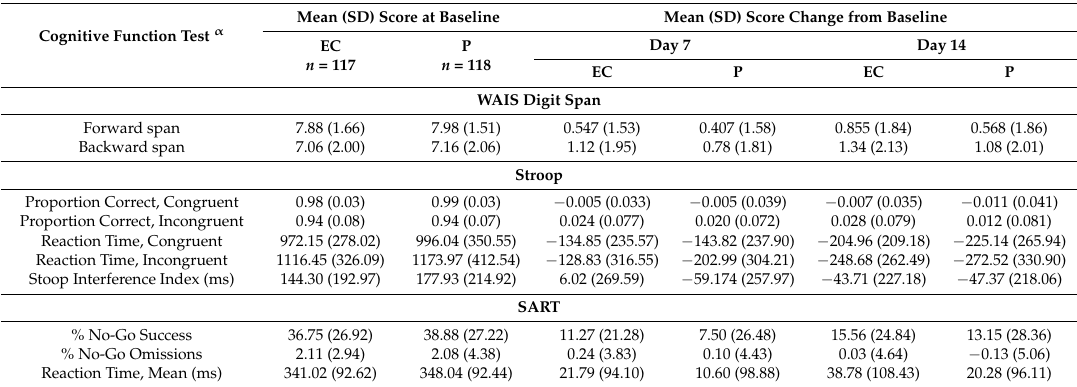
Table 3. Baseline and change scores of cognitive function test parameters at Days 7 and 14 in the Essence of Chicken (EC) and Placebo (P) groups.